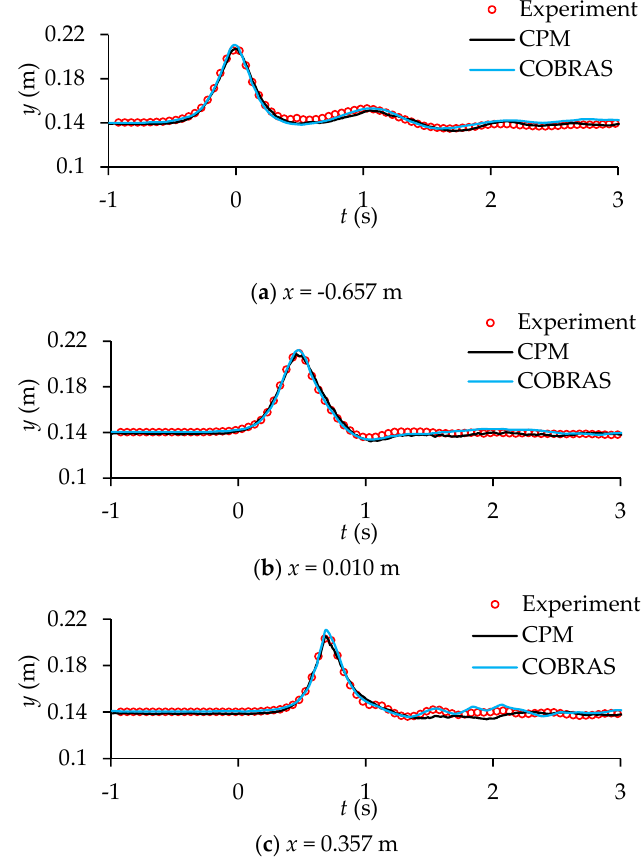
Figure 2. Wave elevations at E1, E2 and E3: ( a ) x = − 0.657 m; ( b ) x = 0.010 m; ( c ) x = 0.357 m. Table 1. Relative differences between the numerical and experimental results of wave crests at E1, E2 and E3.